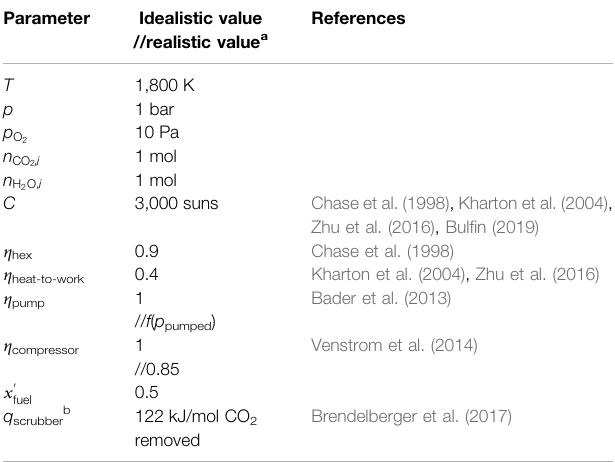
TABLE 2 | Baseline parameters used in thermodynamic ef fi ciency